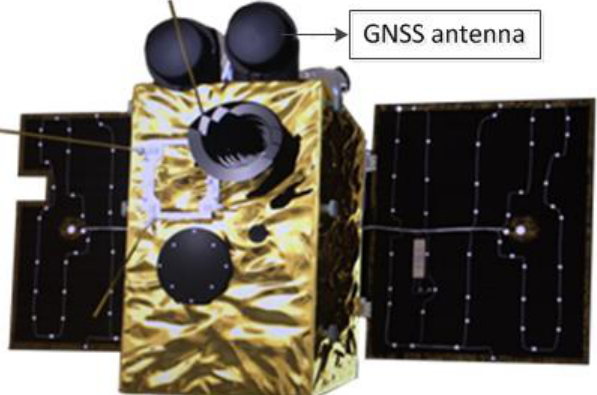
Figure 5. Outlook configuration of the Luojia-1A satellite and the GNSS antenna.